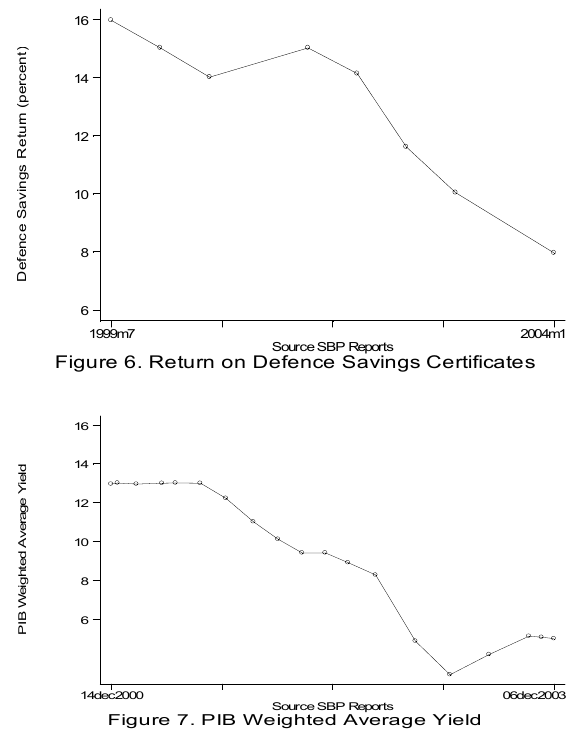
Source SBP Figure 7. PIB Weighted Average Yield